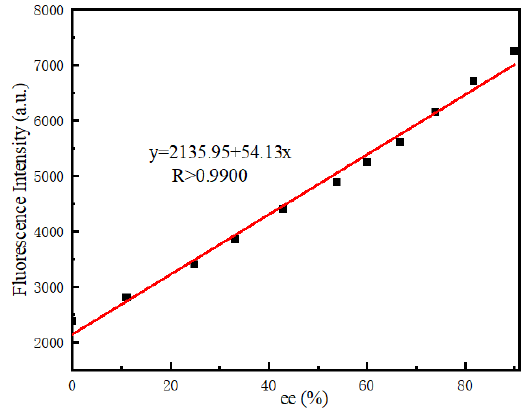
Figure 3. Fluorescence response at λ ex = 389 nm for the mixtures of R - 1 toward L -Lys (100.0 equiv.) at various ee values.